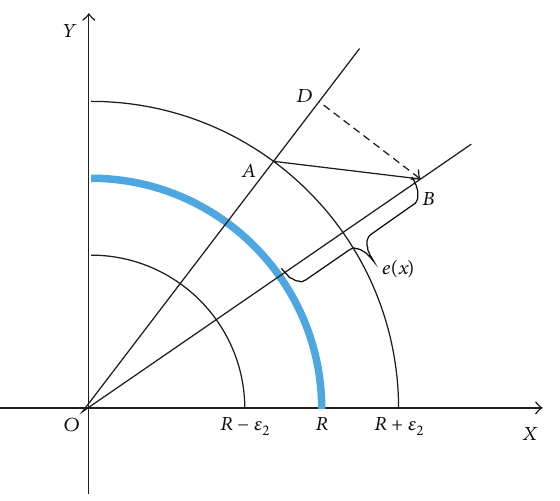
Figure 3: Illustration of the need for 𝜑 1 . Figure 4: Illustration of the need for 𝜑 2 .